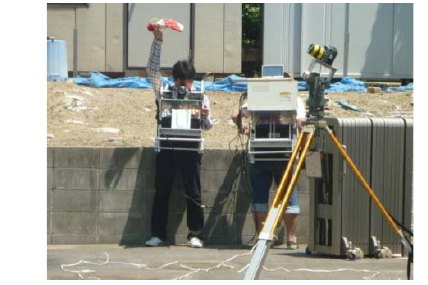
Figure 13. View of experiment